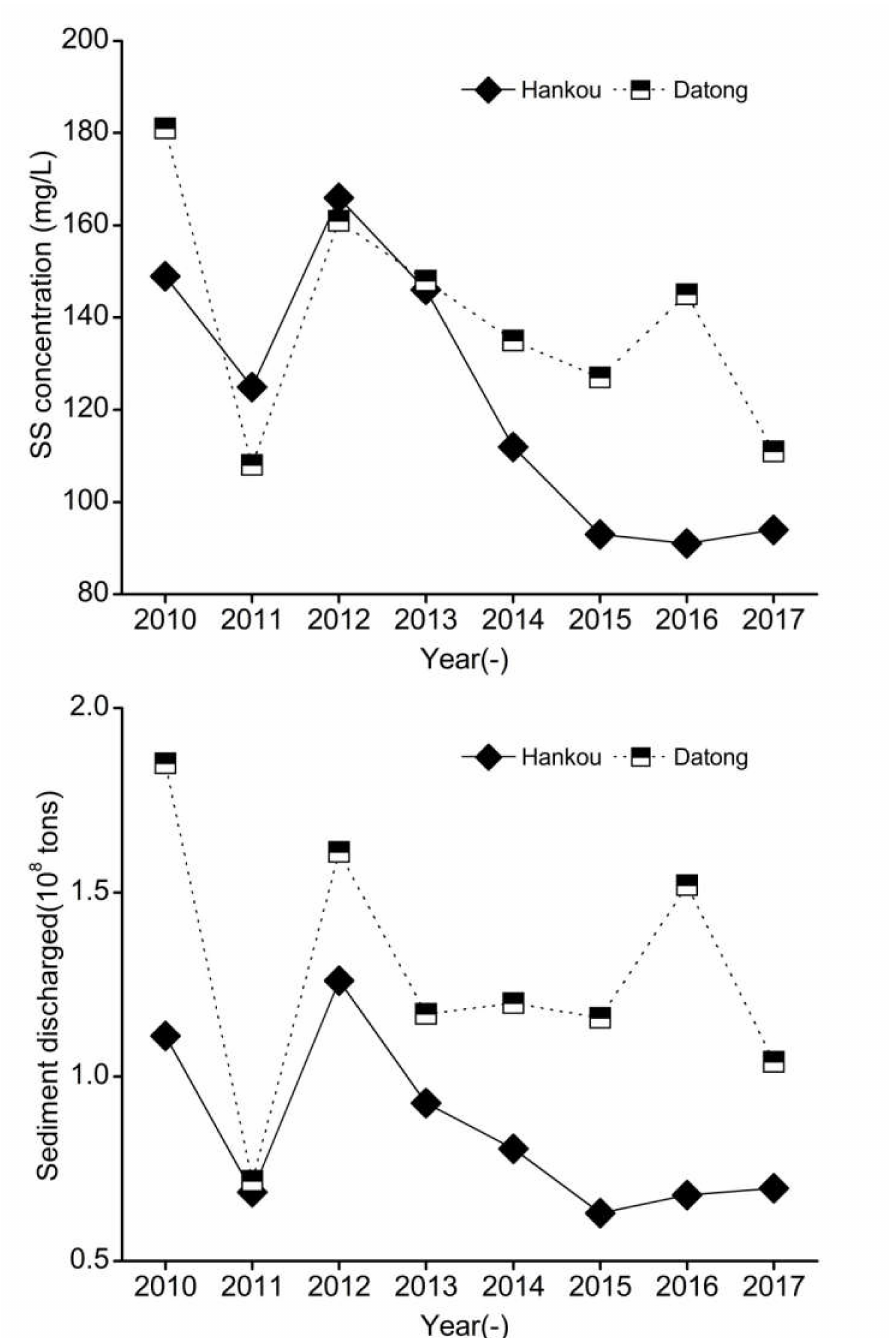
Figure 8. Variations in the annual mean SS concentrations and total sediment discharged volumes between 2010 and